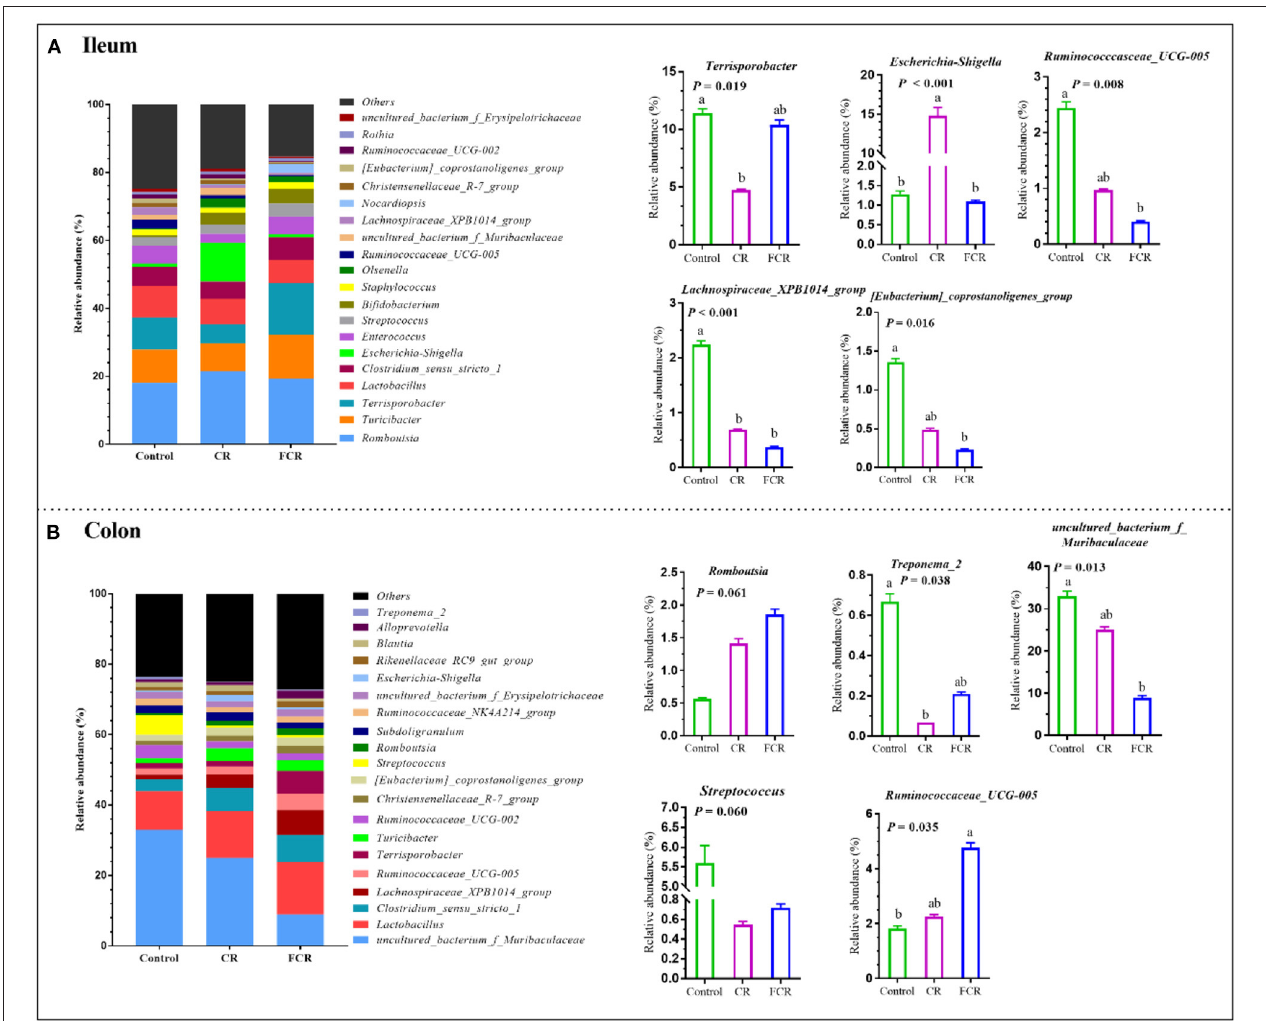
FIGURE 3 | The relative abundance of piglets’ ileal (A) and colonic (B) microbiota community and taxonomic differences at the genus level ( n = 7–8). The data are presented as the means ± SEM, and values with different letters mean significant difference ( P <